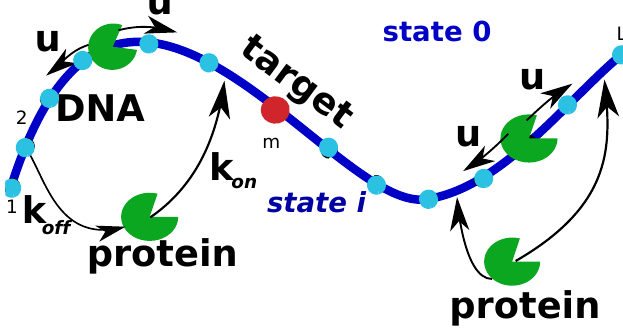
Figure 1. A schematic view of a minimal discrete-state stochastic model of the protein search for targets om DNA. The DNA chain has L − 1 non-specific binding sites and one specific target site. A protein molecule can diffuse along the DNA segment with a rate u in both directions. It can also associate to DNA from the bulk solution (labeled as state 0) with a rate k on or it can dissociate back to the solution with a rate k of f . The search is finished when the protein binds to the target site at the position m for the first